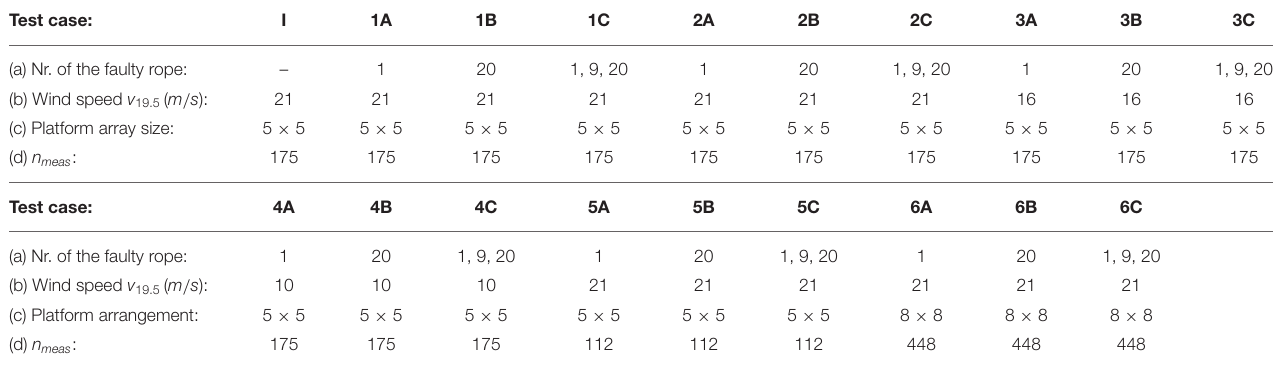
TABLE 2 | Test cases for the